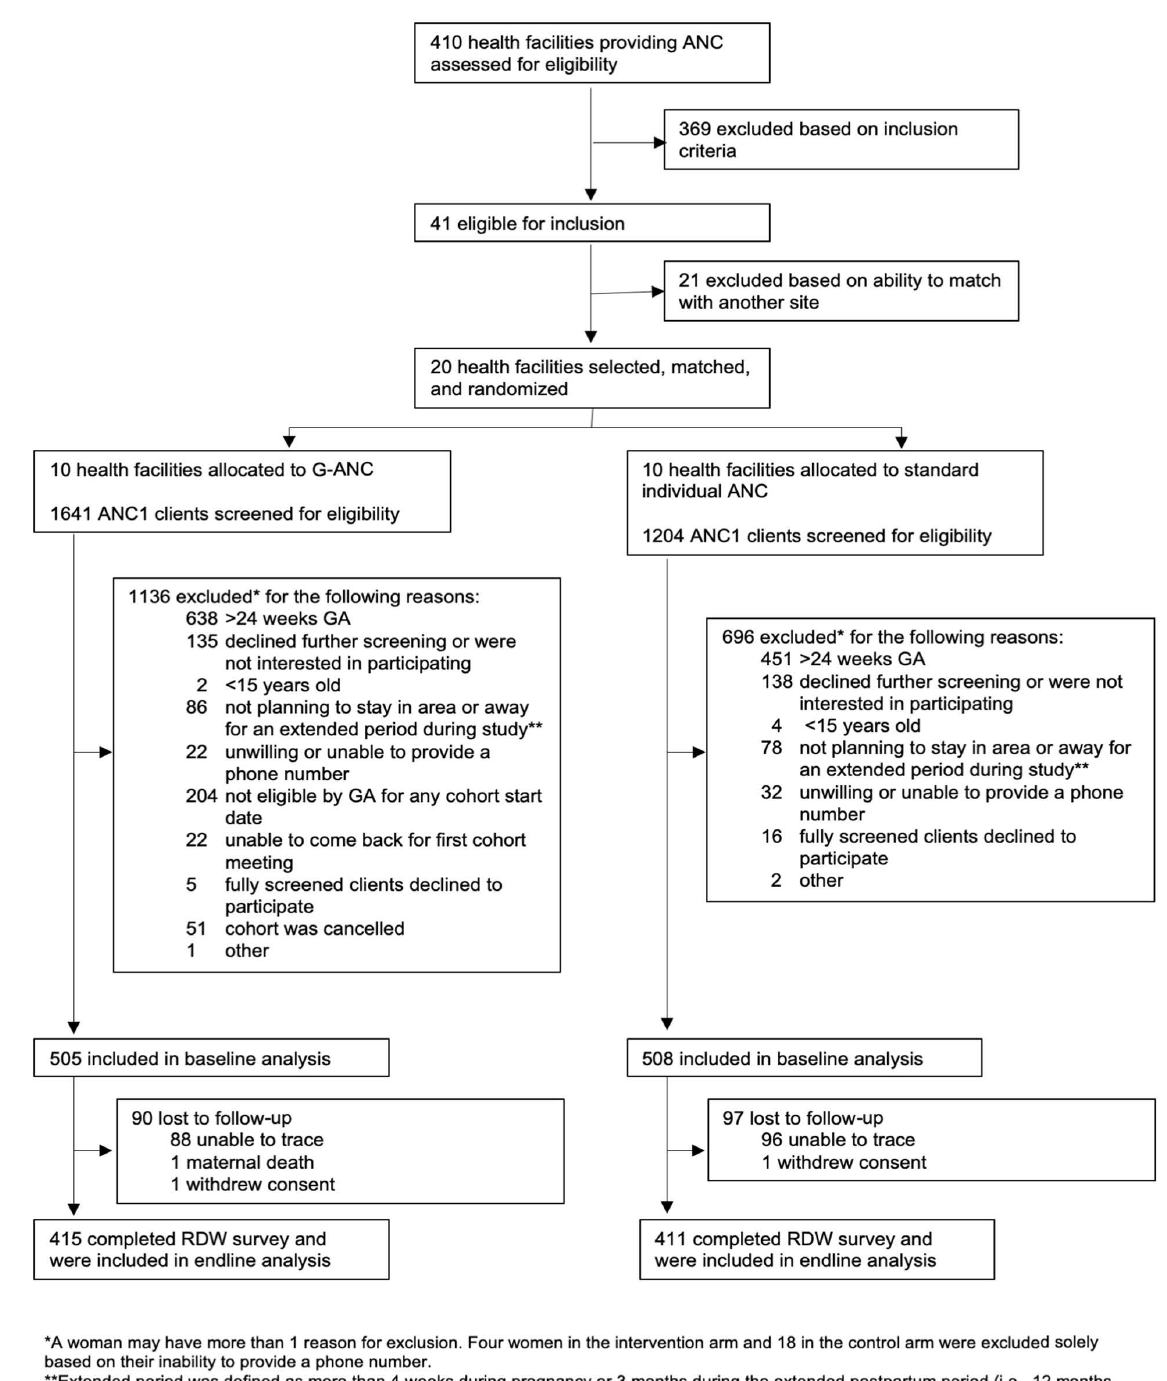
Figure 2. Enrollment of study participants in Kenya. CONSORT flowchart of the eligibility screening, consent, and enrolment of study participants in